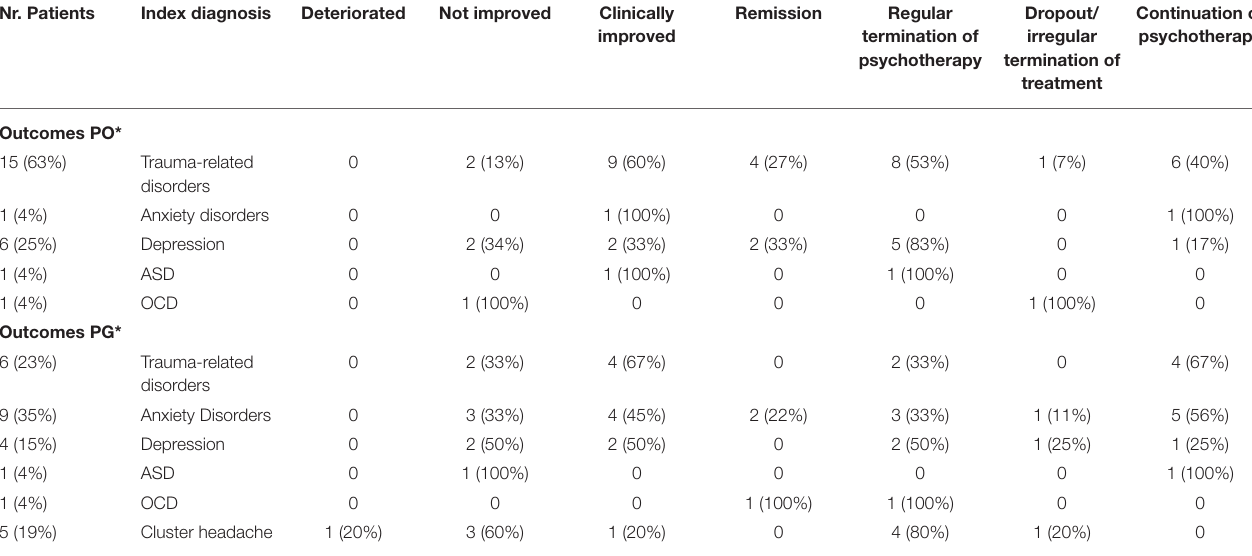
TABLE 3 | Outcomes as assessed by clinical judgement in regard to overall symptom reduction and general well-being. Nr.